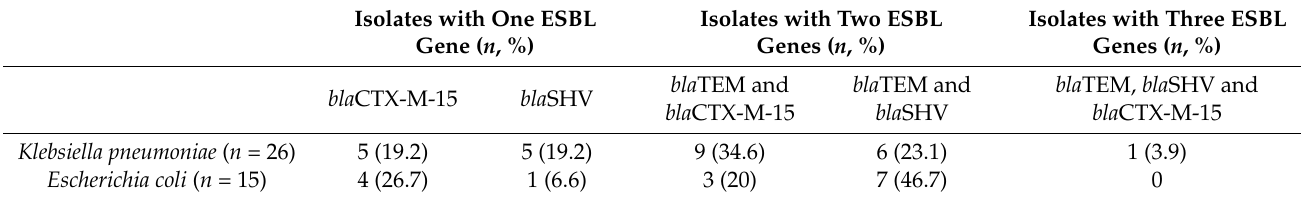
Table 1. Distribution of major ESBL-encoding genes among Klebsiella pneumoniae and Escherichia coli isolates. Isolates with One ESBL Isolates with Two ESBL Isolates with Three ESBL Gene ( n , %) Genes ( n , %) Genes ( n , %) bla TEM bla CTX-M-15 bla SHV